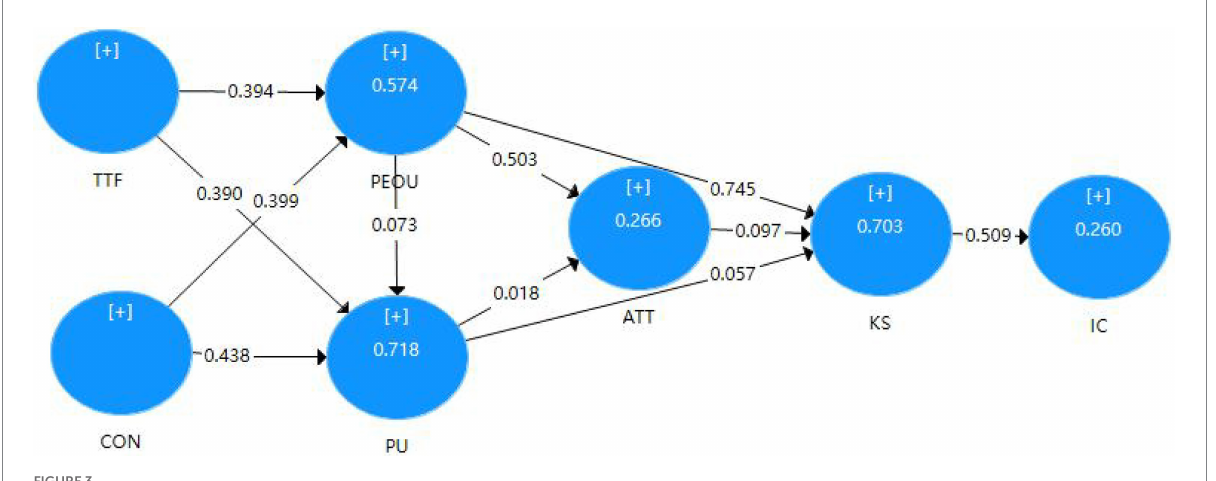
FIGURE 3 Path model result of